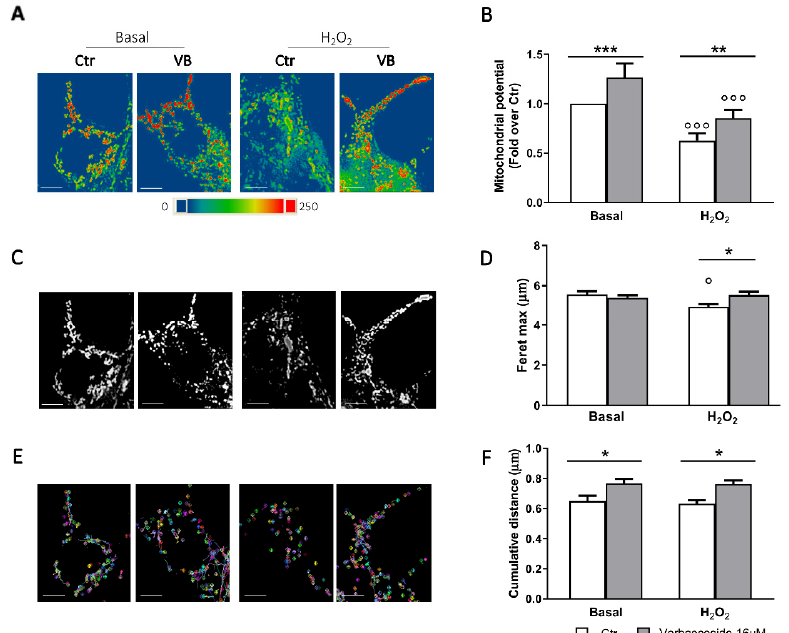
Figure 4. Verbascoside modulates mitochondrial activity, morphology and dynamics. Mouse β tc3 cells were treated with 16 µ M verbascoside (VB) for 5 days and then loaded with 100 nM MitoSpy ™ Orange CMTMRos. ( A ) Representative images of mitochondria in pseudocolors are shown (blue low intensity, red high intensity). Bar: 5 µ m. ( B ) Quantitative analysis of mitochondrial membrane potential measured by fluorimetry (551/576 nm Ex/Em). Data (mean ± SD) were normalized to mitochondrial mass and expressed as fold change over control (n = 4 independent experiments). (Two-way ANOVA post-hoc Tukey’s test ◦◦◦ p < 0.0001 H 2 O 2 vs. Basal; ** p = 0.002, ***p = 0.0002 VB vs. Ctr). ( C ) Representative epifluorescence images of mitochondria are shown. Bar: 5 µ m. ( D ) Quantitative analysis of mitochondrial Feret’s maximum diameter ( µ m); bars illustrate the average responses ± SEM (n = 10-15 cells in three independent experiments). (Two-way ANOVA, post-hoc Tukey’s test. ◦ p = 0.02 H 2 O 2 vs. Basal; * p = 0.02 VB vs. Ctr). ( E ) Video tracking of mitochondrial movements during the 30 s record. Bar: 5 µ m. ( F ) Quantitative analyses of mitochondria movements. Bars illustrate the average response (cumulative distance) ± SEM of three independent experiments. (Two-way ANOVA, post-hoc Tukey’s test. * p = 0.02 VB vs.